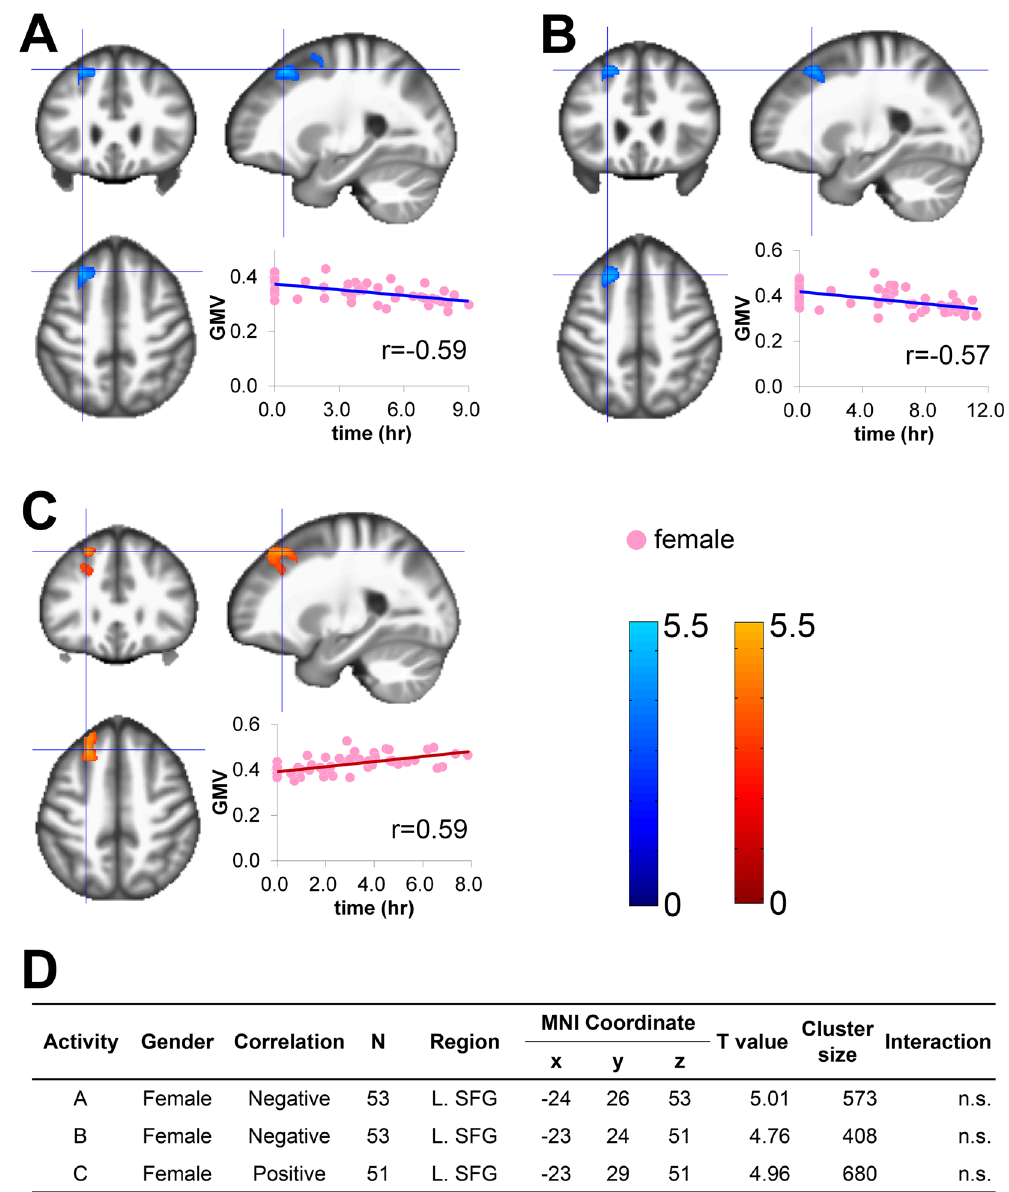
Figure 1. Sex-specific correlations between grey matter volume (GMV) and each item in main activities. Regions that survived a statistical threshold of p < 0.05 (cluster-level corrected for multiple comparisons) are shown with ( A ) daily time of Job-work in females, ( B ) weekly range of daily time of Job-work in females, and ( C ) daily time of Domestic work in females ( D ) Summary of the significant correlations. The X-axis of the scatter plot indicates the daily time or weekly range of activities. The Y-axis indicates the extracted GMV over the peak coordinates of the significant cluster. L, left; MNI, Montreal Neurological Institute; SFG, superior frontal gyrus; n.s.: not